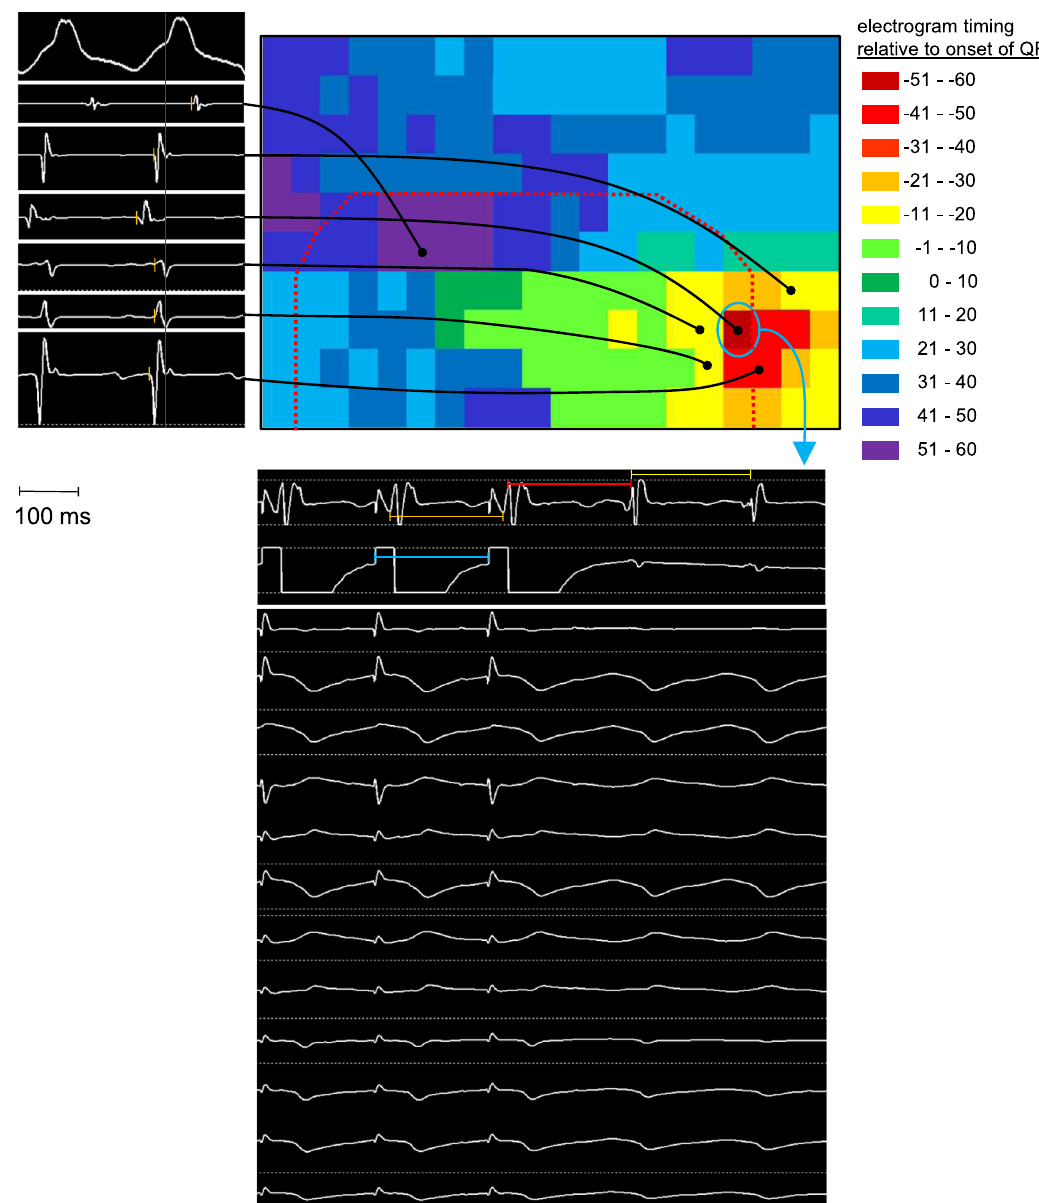
Fig. 1 The schematic depicts the VT mapping process, including example electrograms (top left), a graphical display of the activation time during VT (top right with markers showing the location of the example electrograms), and entrainment pacing from the site of earliest activation (local electrograms in the middle panel and 12-lead ECG at bottom). The activation mapping process started by moving the catheter throughout the heart during VT, recording electrogram and marking catheter location at each site, and measuring the timing of each electrogram (top left panel, orange lines) against a fi duciary point in the surface ECG (red line in the top left panel). The activation time and location for each point was displayed graphically (top right). Overlaid on the activation map is the edge of the infarct scar (red dotted line) obtained from a separately performed sinus rhythm voltage map. After identifying earliest activation (blue circle in top right panel), we placed the catheter at that location and paced during VT at an output just above threshold and a cycle length 10 ms faster than the tachycardia cycle length. Local electrograms were recorded from the pacing electrodes and the closest adjacent bipole (middle panel). Local capture was con fi rmed by comparing the timing of the pacing stimulus (blue bar = 180 ms) to the adjacent electrogram (orange bar = 180 ms). Concealed entrainment criteria were met if the timing of the fi rst return beat after pacing (red bar = 196 ms) was within 20 ms of the tachycardia cycle length (yellow bar = 190 ms), and if the paced QRS morphology exactly matched the VT morphology (bottom panel). (two from the transmural surface of LV free wall wedges, one (Fig. 4a – b). The pattern of distinct short APD (103 ± 25) and long from the transmural surface of the ventricular septum, and one APD (233 ± 54) tracts persisted during VT. In the remaining 42 from the LV free wall endocardium). All of the observed VT optical maps obtained from borderzone tissue wedges in VT- circuits had a tract of cells with short APDs (average across all group animals, 28 came from wedges that had inducible VT, and animals with full VT circuits: 228 ± 835 ms) adjacent to a tract 14 came from wedges without inducible VT. In the wedges where with long APDs (496 ± 65 ms) during steady rate pacing that VT was induced but the full circuit was not visible (Fig. 4c), 11 corresponded to the two limbs of the reentrant circuit during VT maps had focal areas of either shorter or longer APDs but not the